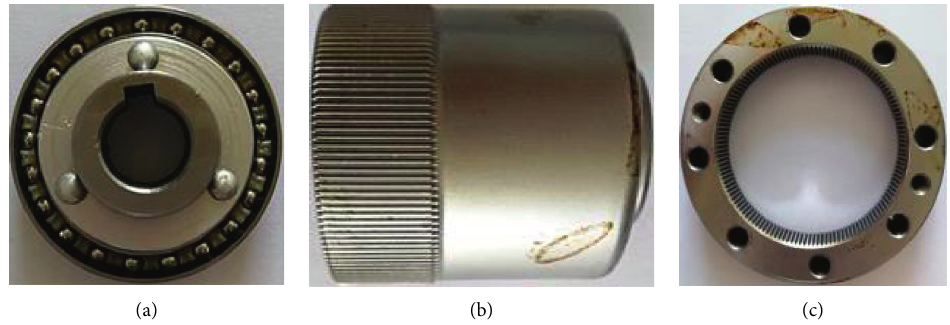
Figure 1: Structure of B 3 -80 harmonic gear reducer. (a) Wave generator. (b) Flexspline. (c) Circular spline.